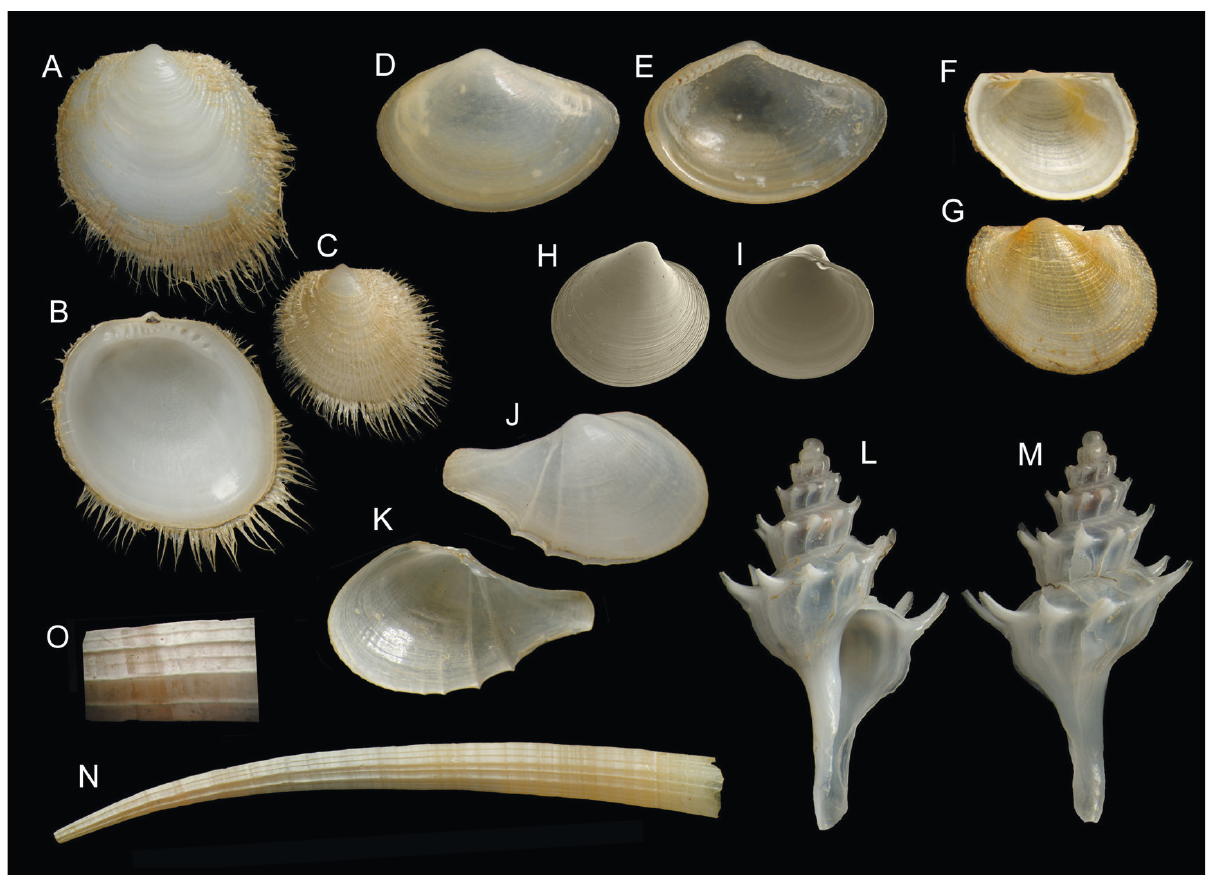
Fig. 3. – Top-dominant and characteristic species from the sediment fraction of haul BT04. A-C: Limopsis aurita (heights 10.0 mm and 6.4 mm). D-E: Yoldiella philippiana (length 5.0 mm). F-G: Bathyarca pectunculoides (lengths 3.4 and 2.8 mm). H-I: Kelliella miliaris (scanning electron micrograph; lengths 1.8 and 1.6 mm); J-K: Cardiomya costellata (length 5.6 mm). L-M: Pagodula echinata (height 8.0 mm), N-O: Antalis panorma (length 39.0 mm) and detail of